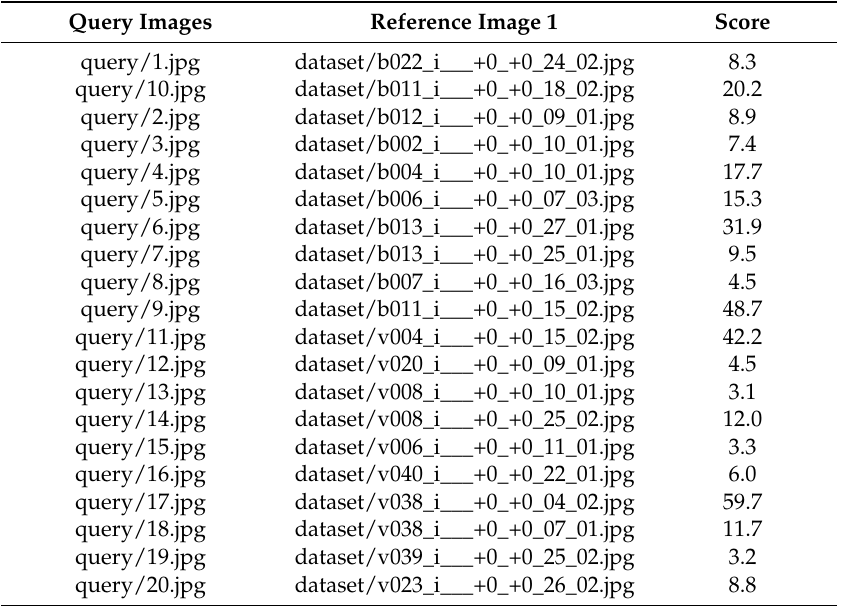
Table 2. Results of reference image extraction from the image DB of Bangbae Station using